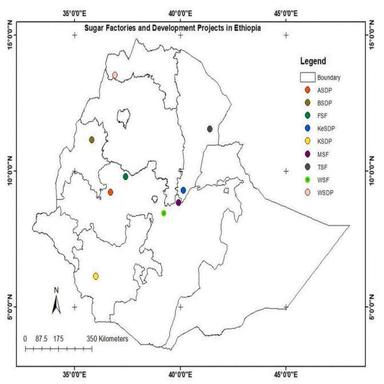
ArcMap of sugar production factories and sugar factory developments in Ethiopia.ASDP= Arjo Sugar Development Project; BSDP= Beles Sugar Development Project; FSF= Fincha Sugar Factory; KeSDP= Kessem Sugar Development Project; KSDP= Kuraz Sugar Development Project; MSF=Methara Sugar Factory; TSF= Tendaho Sugar Factory; WSF= Wonji Sugar Factory; WSDP= Wolkyiet Sugar Development Project.